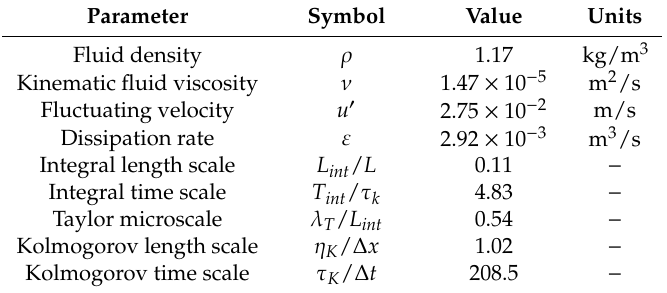
Table 1. Turbulence characteristics of the Lattice Boltzmann Method (LBM)-based Direct Numerical Simulation (DNS).